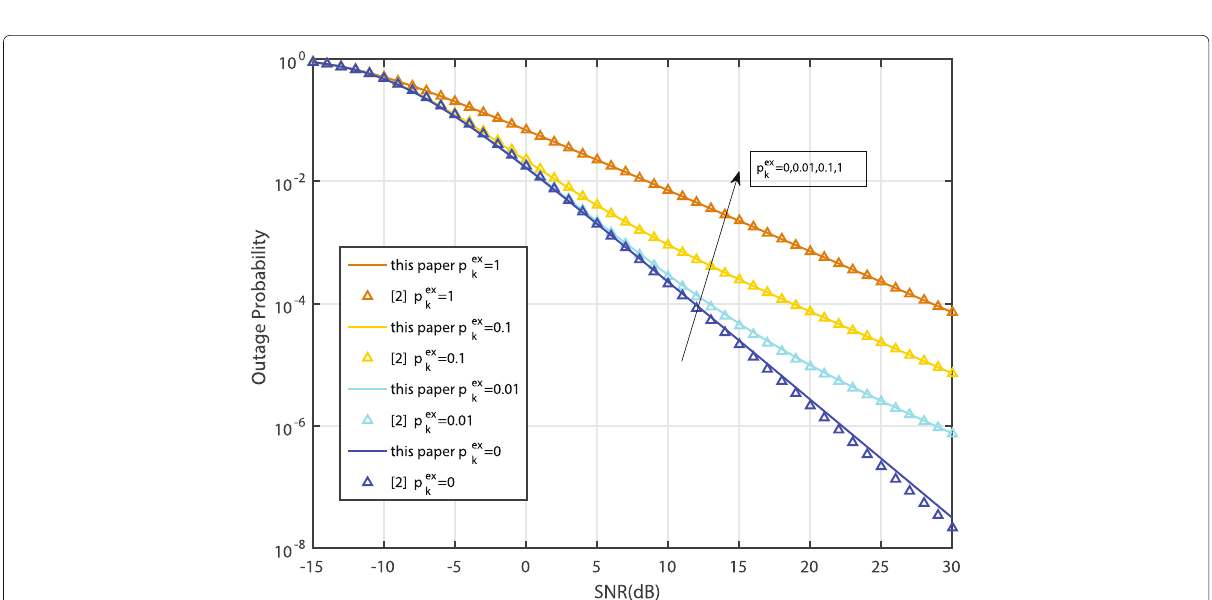
Fig. 3 Outage probability of dual hop energy-harvesting AF relay-aided systems compare with [2] at m sd = 1, m s p ex 1 = { 0,0.01,0.1,1 } , k =